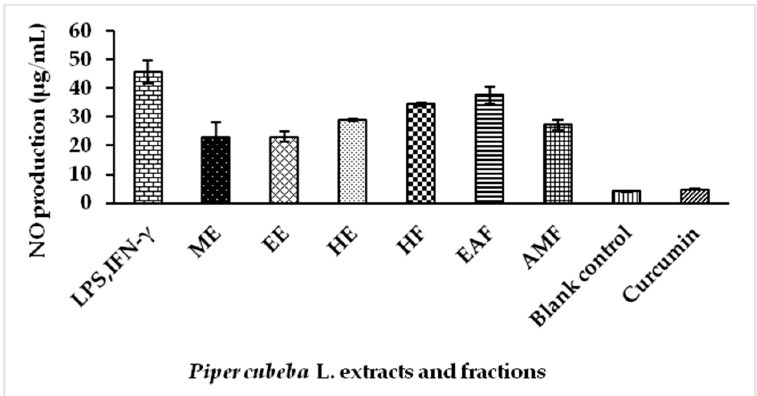
Figure 1. NO production by P. cubeba L. extracts and fractions of in lipopolysaccharide (LPS) stimulated RAW 264.7 cells at 62.5 µg/mL.ME: methanol extract; EE: ethanol extract; HE: hexane extract; HF: hexane fraction; EAF: ethyl acetate fraction; AMF: aqueous methanol fraction.